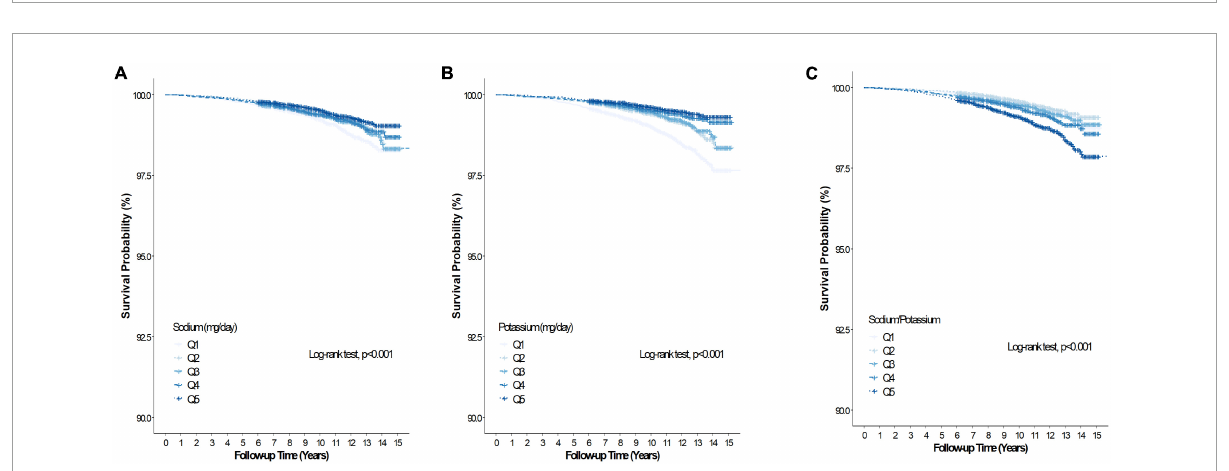
FIGURE3 Kaplan–Meier curve of the association between salt intake and cardiovascular disease mortality. (A) Association between dietary sodium and cardiovascular disease mortality. (B) Association between dietary potassium and cardiovascular disease mortality. (C) Association between dietary Na/K ratio and cardiovascular disease